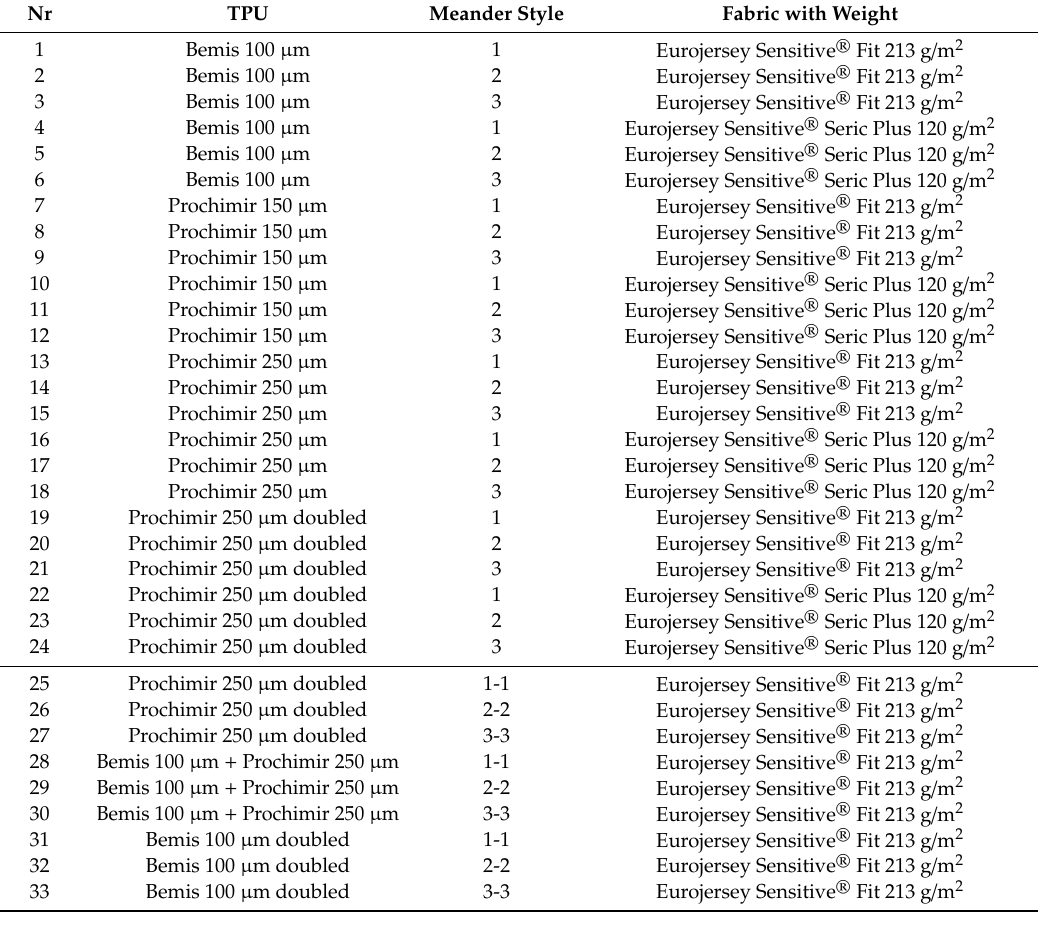
Table 4. Overview of experimental work